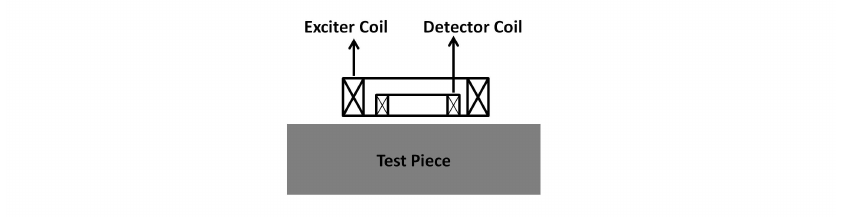
Figure 1. Cross-sectional view of a typical exciter-detector coil-based PEC sensor.